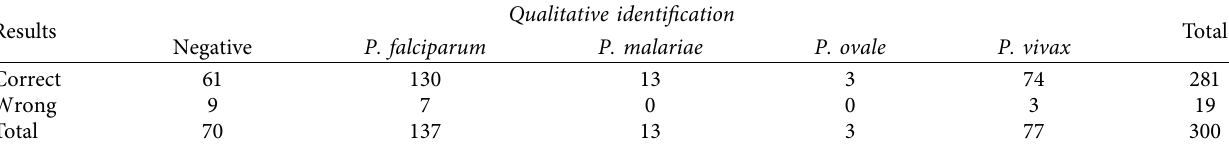
Table 1: Qualitative identification based on malaria microscopy by representatives from provincial CDCs/IPDs.